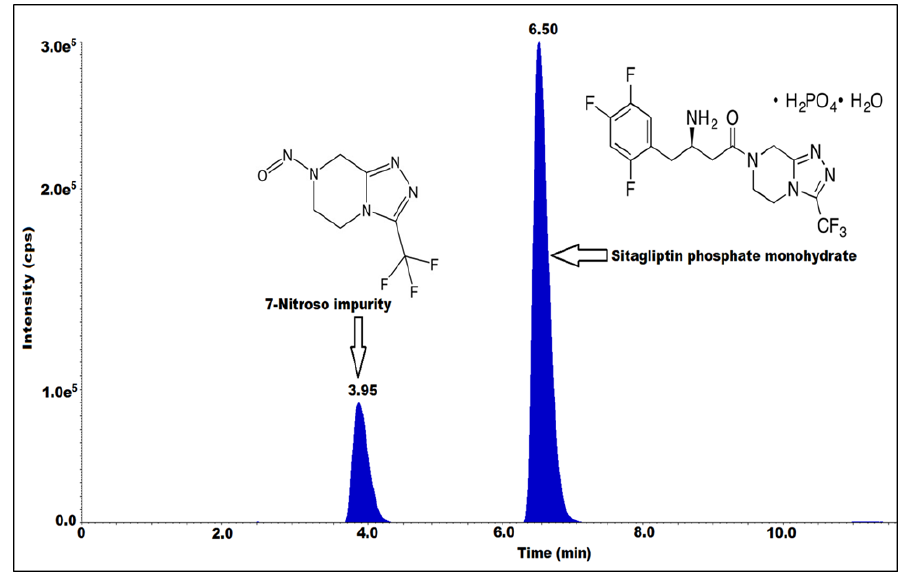
Figure 1. Structures of sitagliptin phosphate monohydrate and 7-nitroso impurity with MRM spectrum.